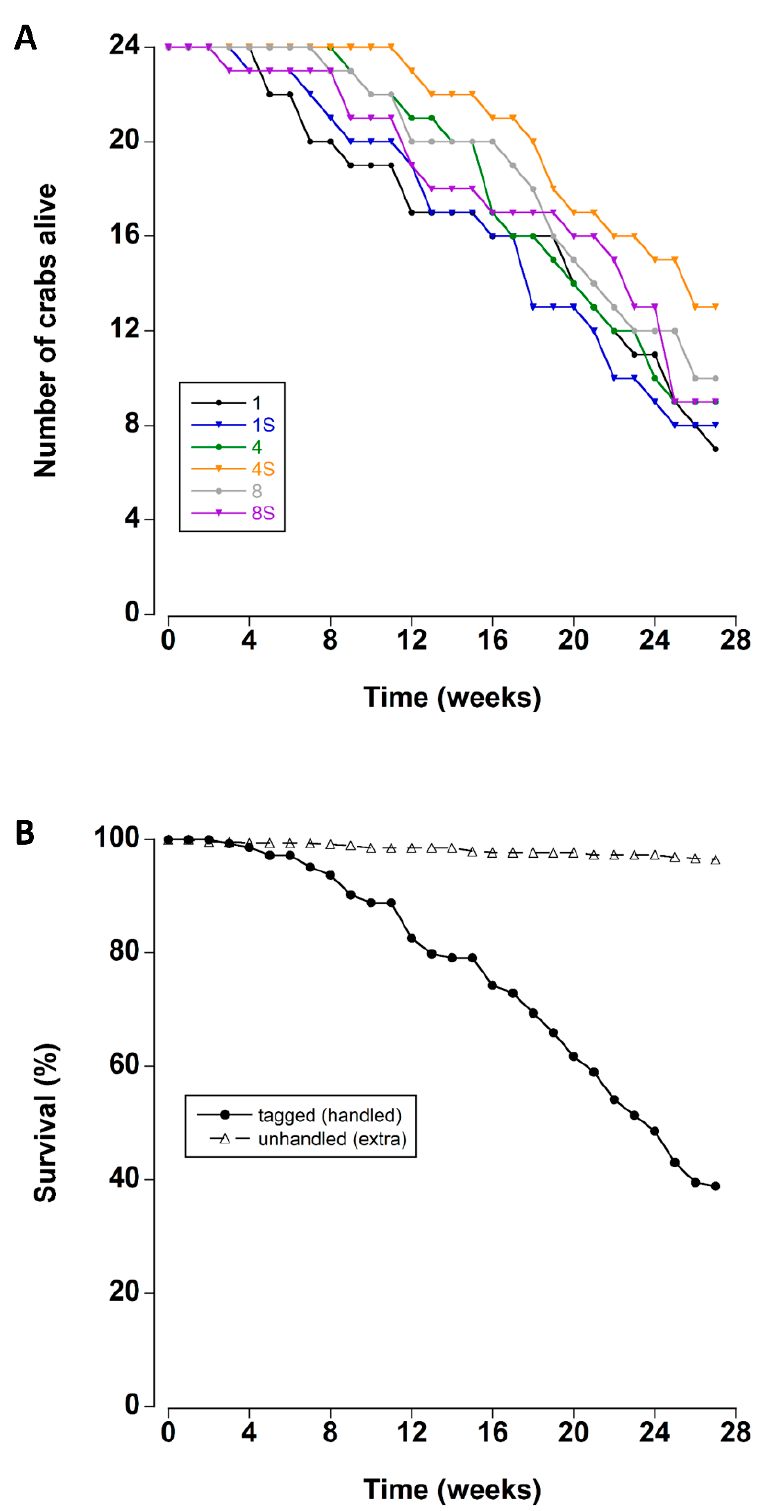
Figure 1. ( A ) Survival rates of adult male C. maenas maintained in the laboratory in densities of 1, 4 or 8 crabs, with (S) or without shelter ( n = 24 per treatment at start of experiment) ( B ) Survival rates (expressed as a percentage) of experimental crabs (tagged/handled) and extra (unhandled, additional animals to maintain density) crabs during a six month period in the laboratory.